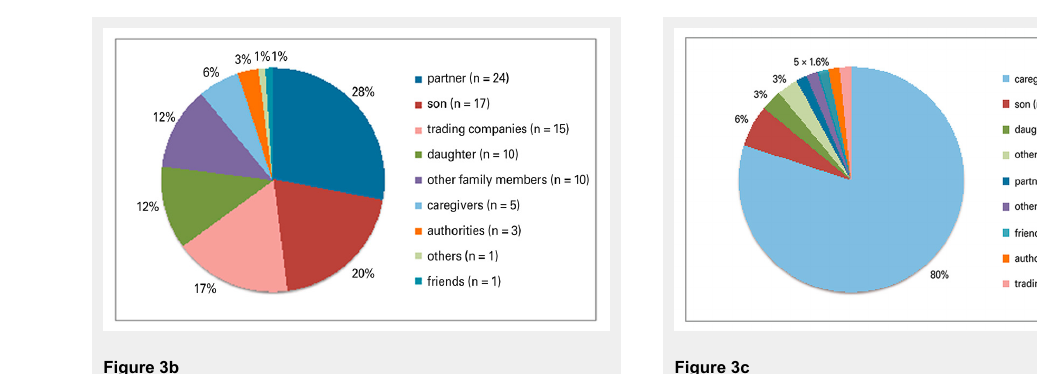
Perpetrators relationship to their victim (living at home, n = 86). Perpetrators relation to their victim (nursing home resident, n =